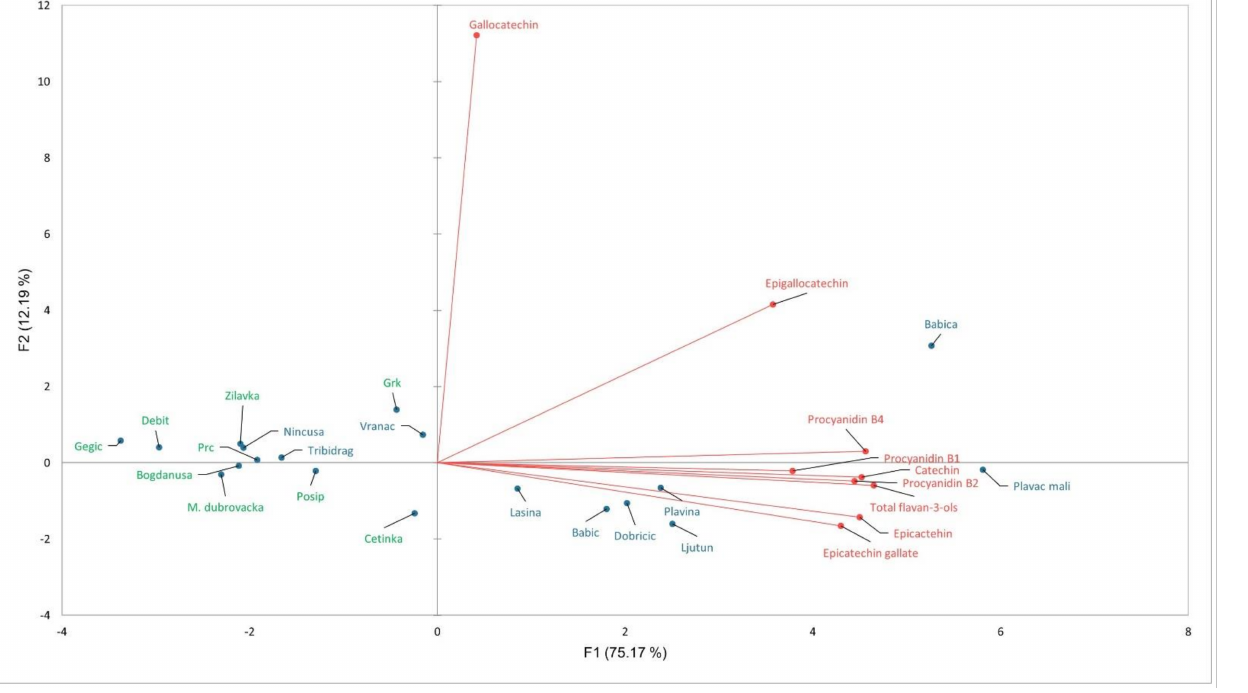
Figure 2. The scatter plot of PCA analysis. Blue shows the red varieties, green shows the white varieties. Half of the varieties are located near the x axis in the quadrants II and III, and most of these varieties are white varieties. A few of the red varieties are situated near white varieties, which are Nincusa, Tribidrag, and Vranac. When looking at their flavan-3-ol profile, these varieties have a similar profile to the white varieties. This means a low content of total flavan-3-ols comparing to the analyzed red varieties. The rest of the red varieties are situated in the IV quadrant. Two more varieties that are separated from the rest of the red varieties are Plavac mali and Babica. When looking at the vectors, these varieties have a higher content of all of the individual compounds, as well as the total flavan-3-ols. These results confirm the overall profile given in Table